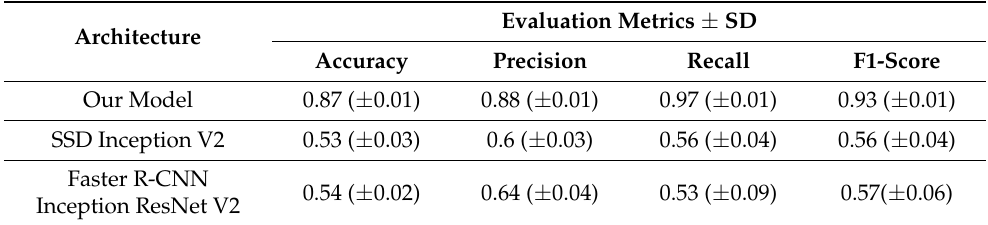
Table 4. Comparison in terms of accuracy, precision, recall, and F1-score